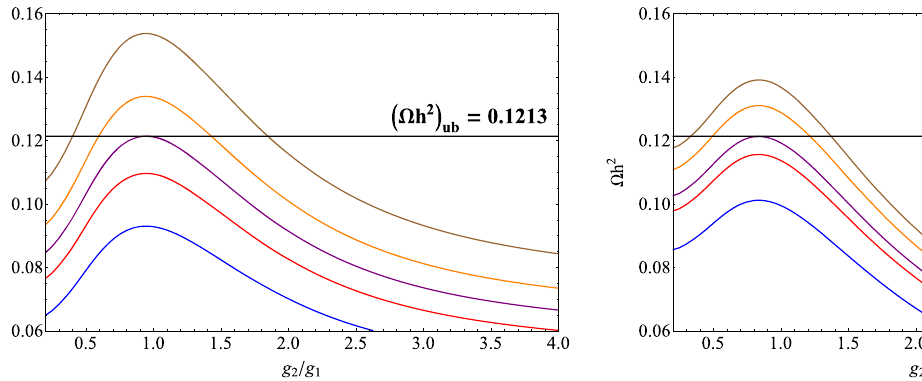
Fig. 5 The DM relic abundance as a function of g 2 / g 1 for various values of the Z (cid:2) boson mass. In the left(right) panel, the blue, red, pur- ple, orange, and brown curevs correspond to M Z (cid:2) = 3 . 5 ( 2 . 9 ) , 3 . 8 ( 3 . 1 ) , 3 . 998 ( 3 . 175 ) , 4 . 2 ( 3 . 3 ) , and 4 . 5 ( 3 . 4 ) TeV, respectively. The black hor-